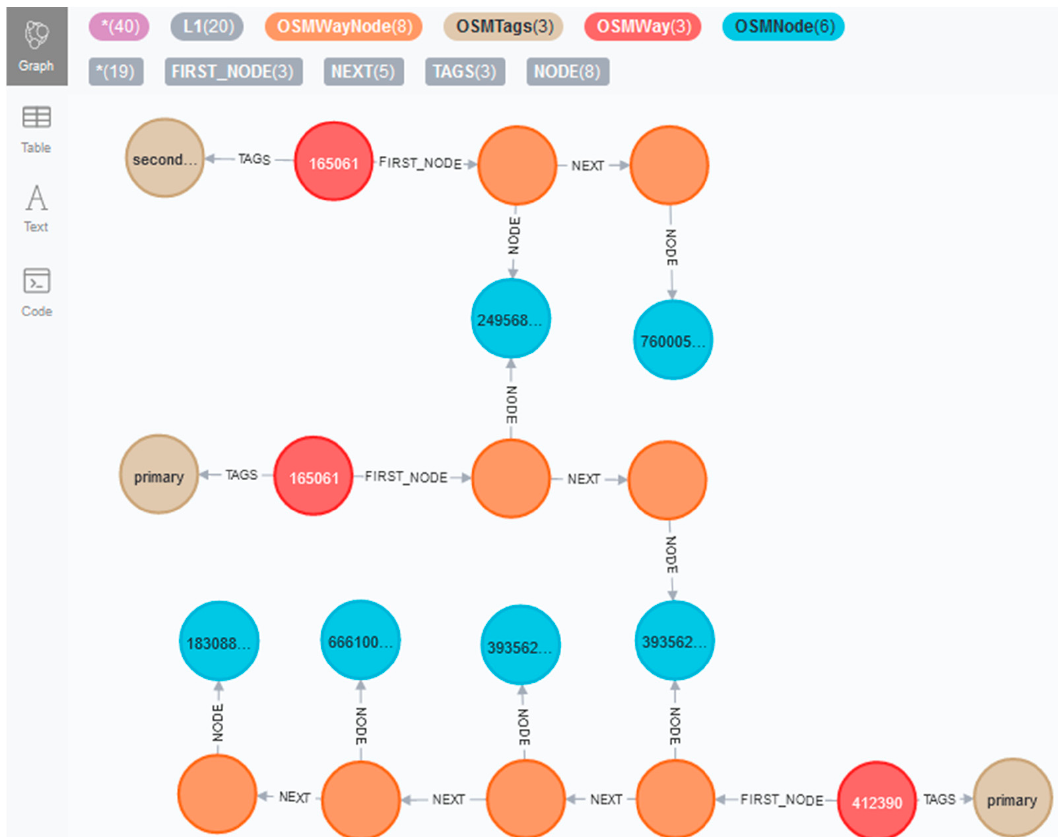
Figure 4. Static layer (L1) data model graph representation snippet in Neo4j. The colour code for the nodes is defined by the neo4j label colours on the top.